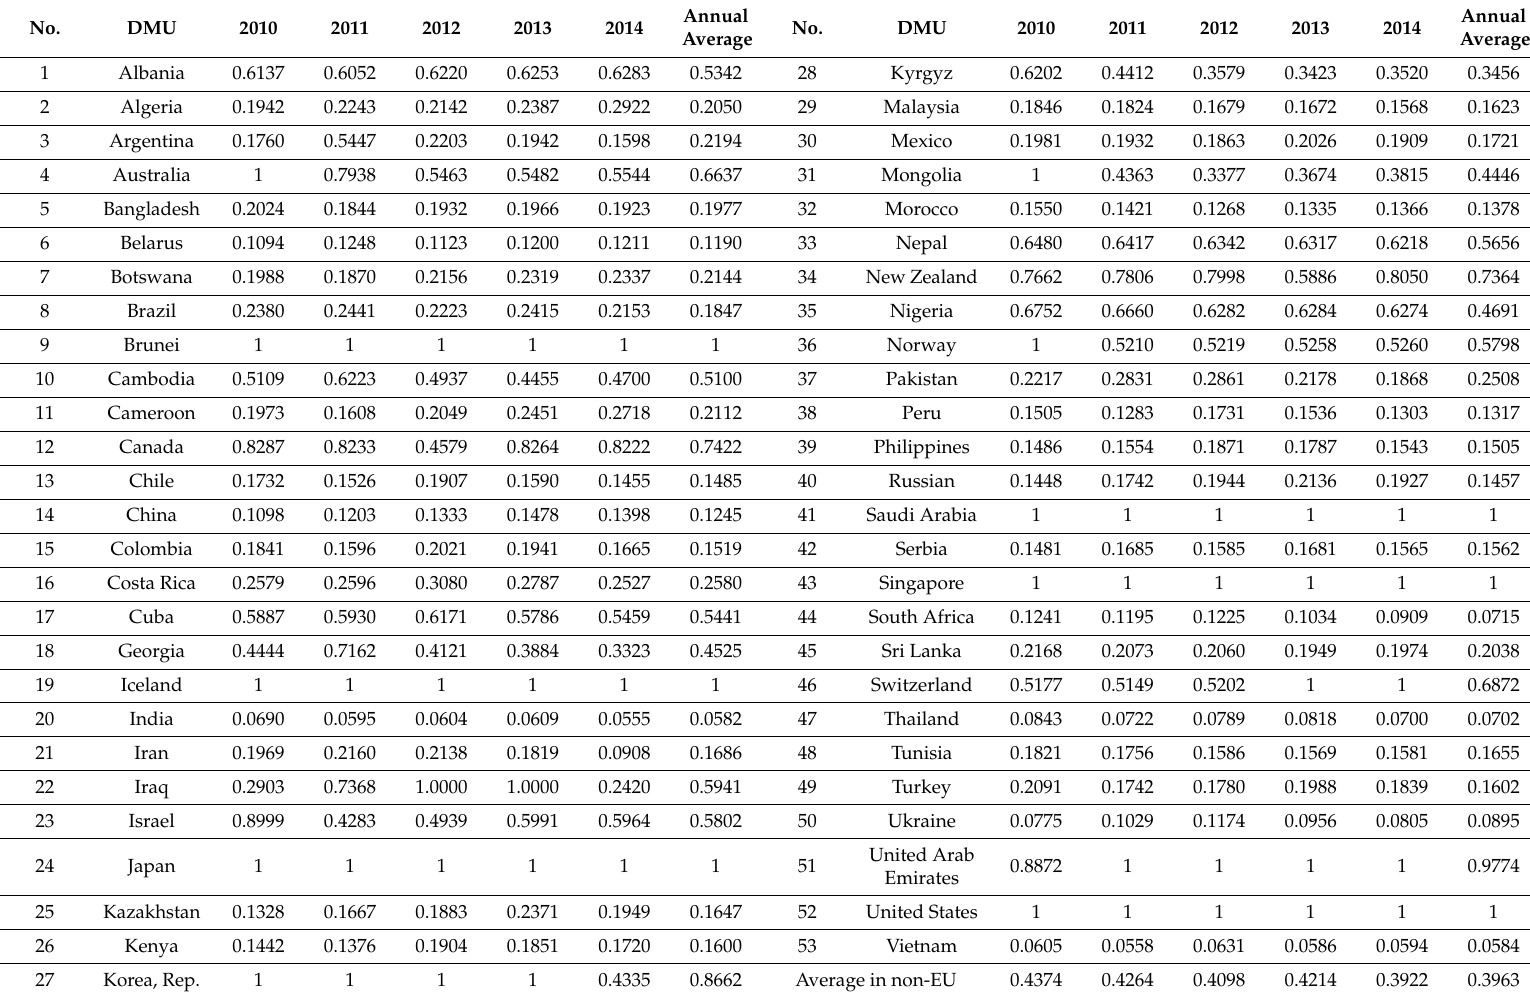
Table 6. Overall e ffi ciency by non-EU countries from 2010 to